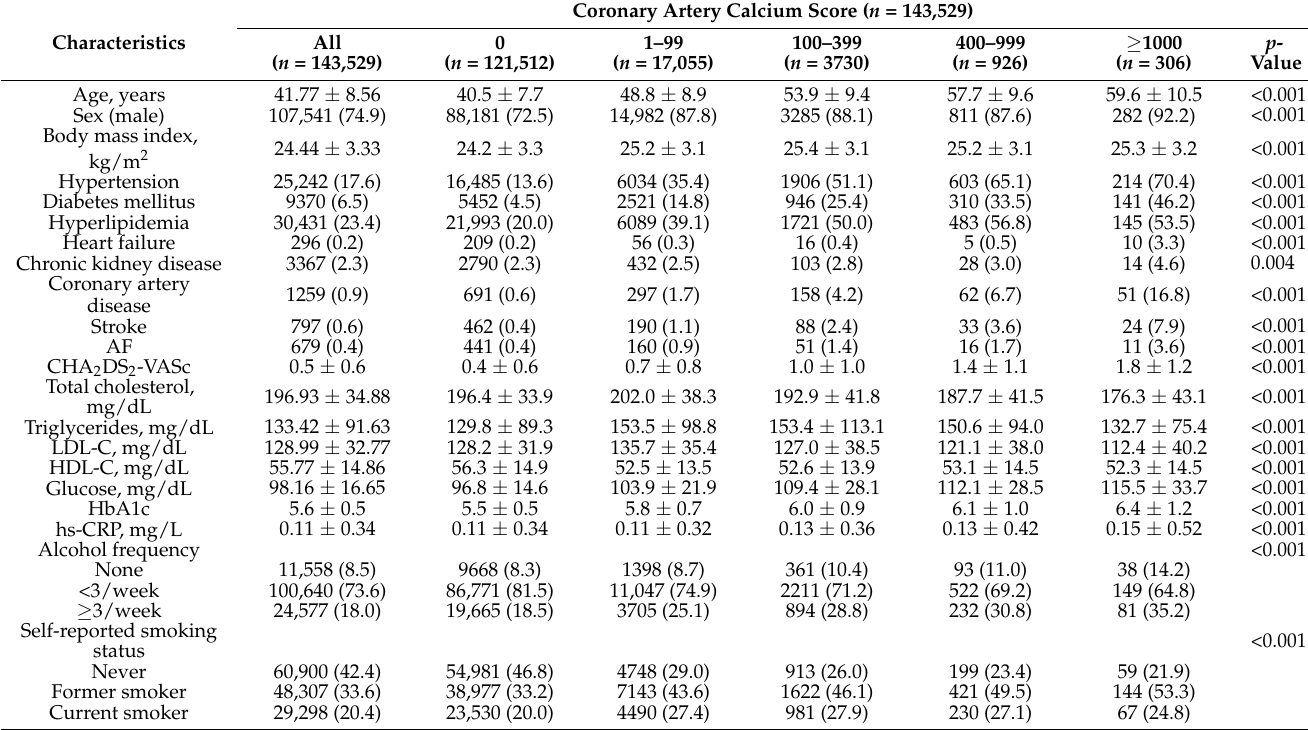
Table 1. Baseline clinical characteristics according to coronary artery calcium score.